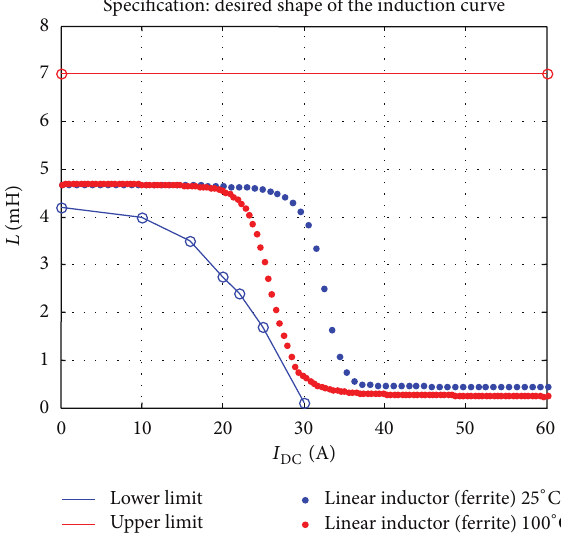
Figure 7: Example specification: Given lower and upper inductance limits with typical inductance curves of a (conventional) linear ferrite inductor at 25 ∘ C and 100 ∘